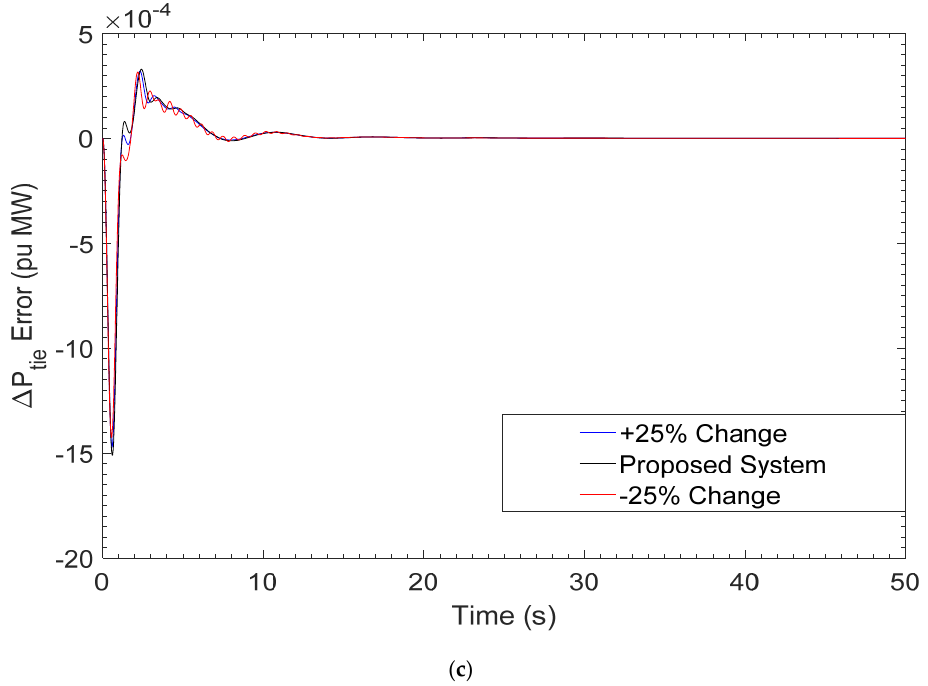
Figure 9. ( a ) Perturbation response of frequency ( Δ F 1 ) with ±25 change in T SG parameter; ( b ) pertur- bation response of frequency ( Δ F 2 ) with ±25 change in T RH parameter; ( c ) perturbation response of tie-line power ( Δ P tie ) with ±25 change in X G parameter.